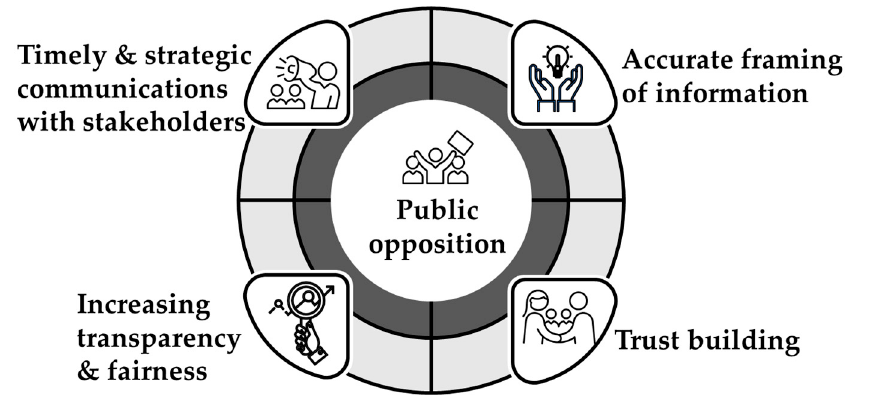
Figure 5. Public participation strategies to manage PO to C&D waste management facilities. Source: